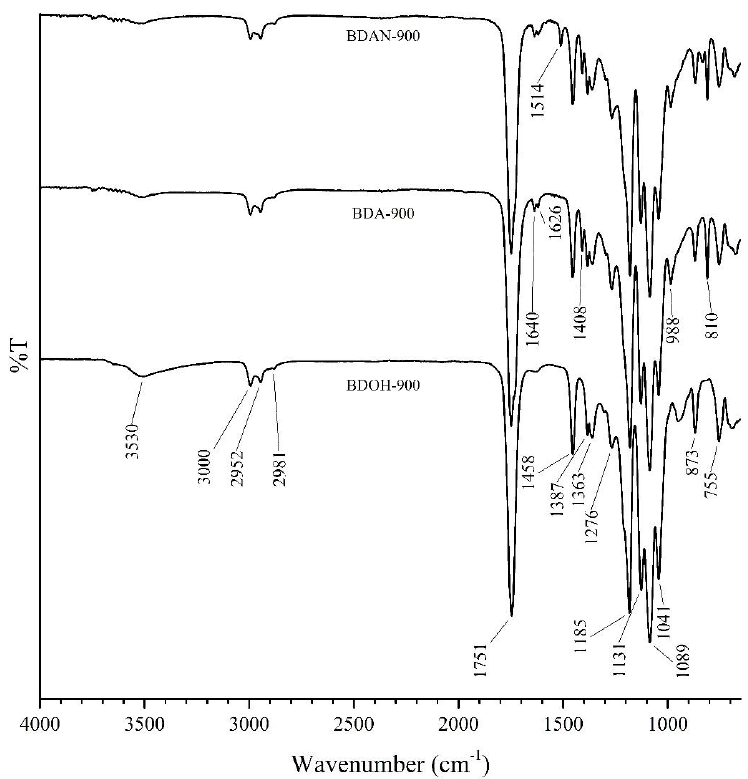
Figure 5. FTIR spectra of BDOH-900, BDA-900, and BDAN-900.